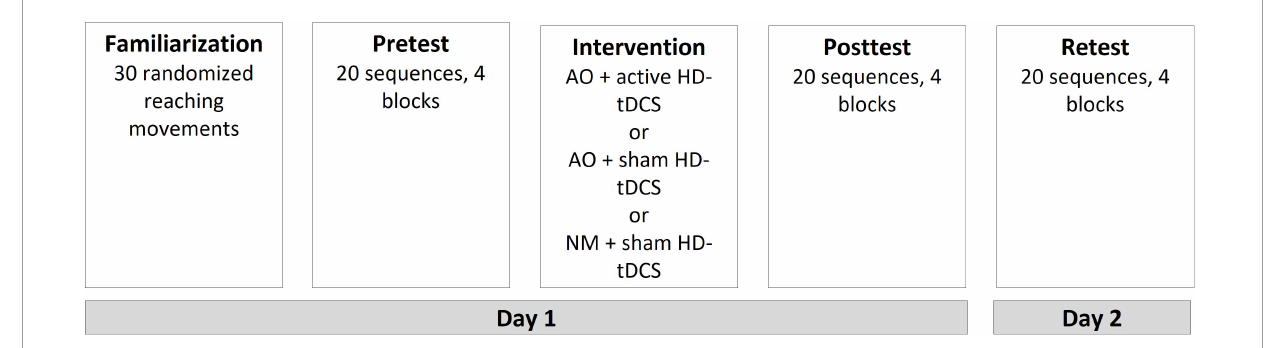
FIGURE2 Experimental procedure. AO, action observation; HD-tDCS, high-definition transcranial stimulation; NM, neutral